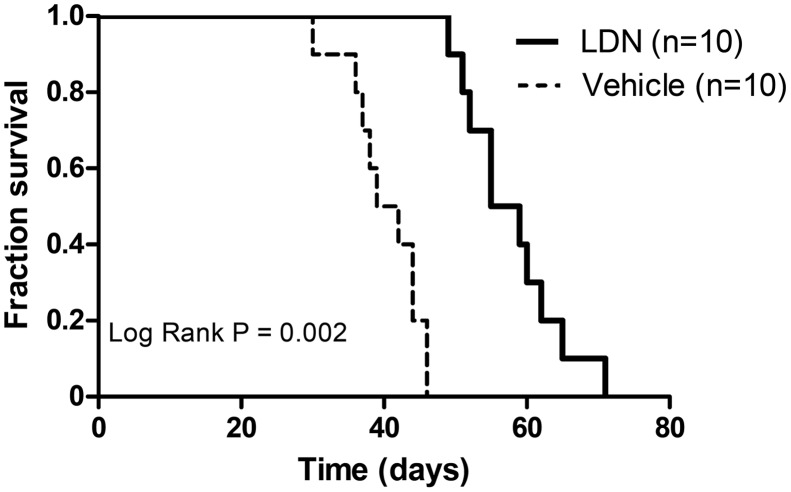
Inhibition of BMP signaling improves survival of MGP-/- mice.MGP-/- mice were treated once daily with LDN-193189 (LDN) or vehicle starting at day 1 of life. Kaplan-Meier survival was compared using the log rank test. MGP-/- mice treated with LDN-193189 survived longer than vehicle-treated mice.